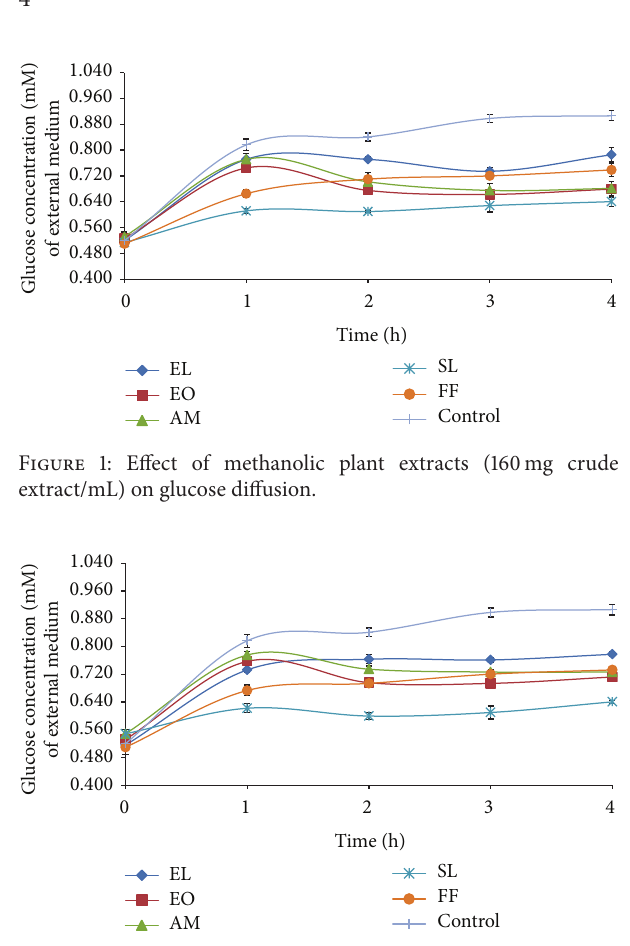
Figure2:Effectofaqueousplantextracts(160 mgcrudeextract/mL) on glucose diffusion. values of methanolic plants against 𝛼 -amylase. Table 1: IC 50 Plant extracts